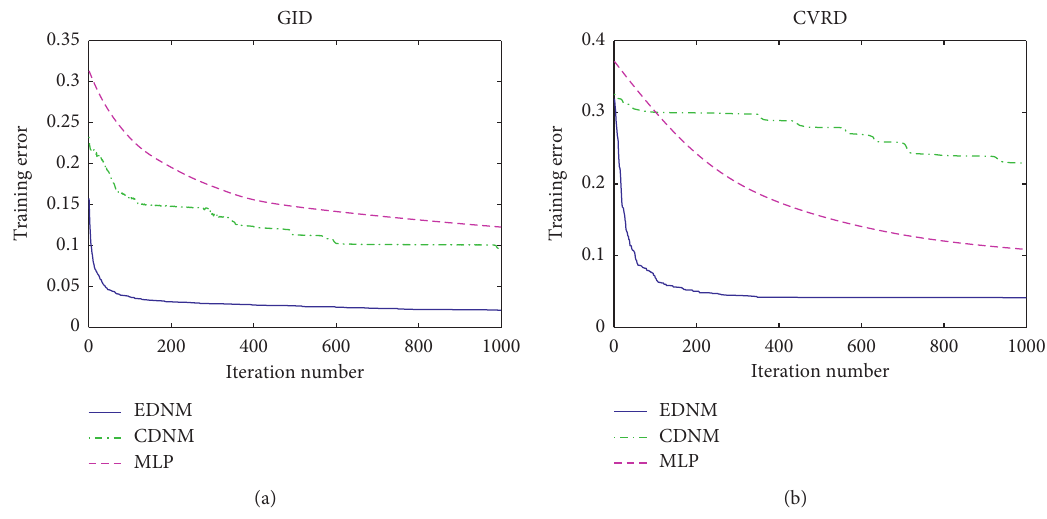
Figure 6: The convergence speeds of EDNM, CDNM, and MLP for GID and